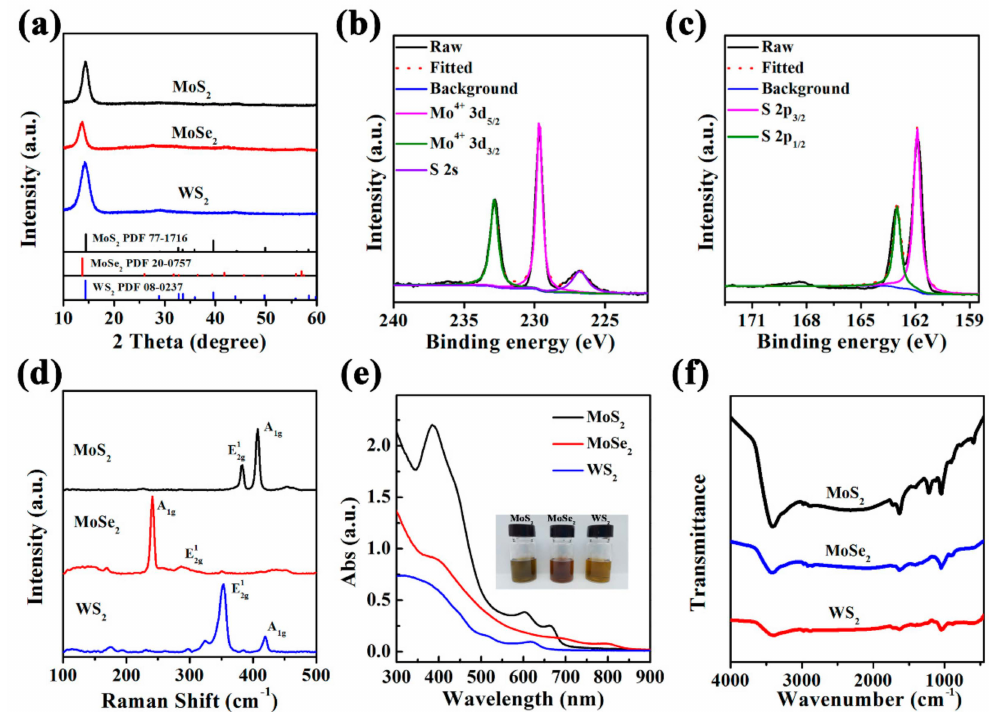
Figure 6. ( a ) XRD patterns of MoS 2 , MoSe 2 , and WS 2 NSs prepared by CMC–assisted ball milling. XPS spectra of MoS 2 NSs for Mo 3d ( b ) and S 2p ( c ) core level energy regions. ( d ) Raman spectra of MoS 2 , MoSe 2 , and WS 2 NSs. ( e ) UV–vis–NIR absorption spectra with the photos (inset) and ( f )